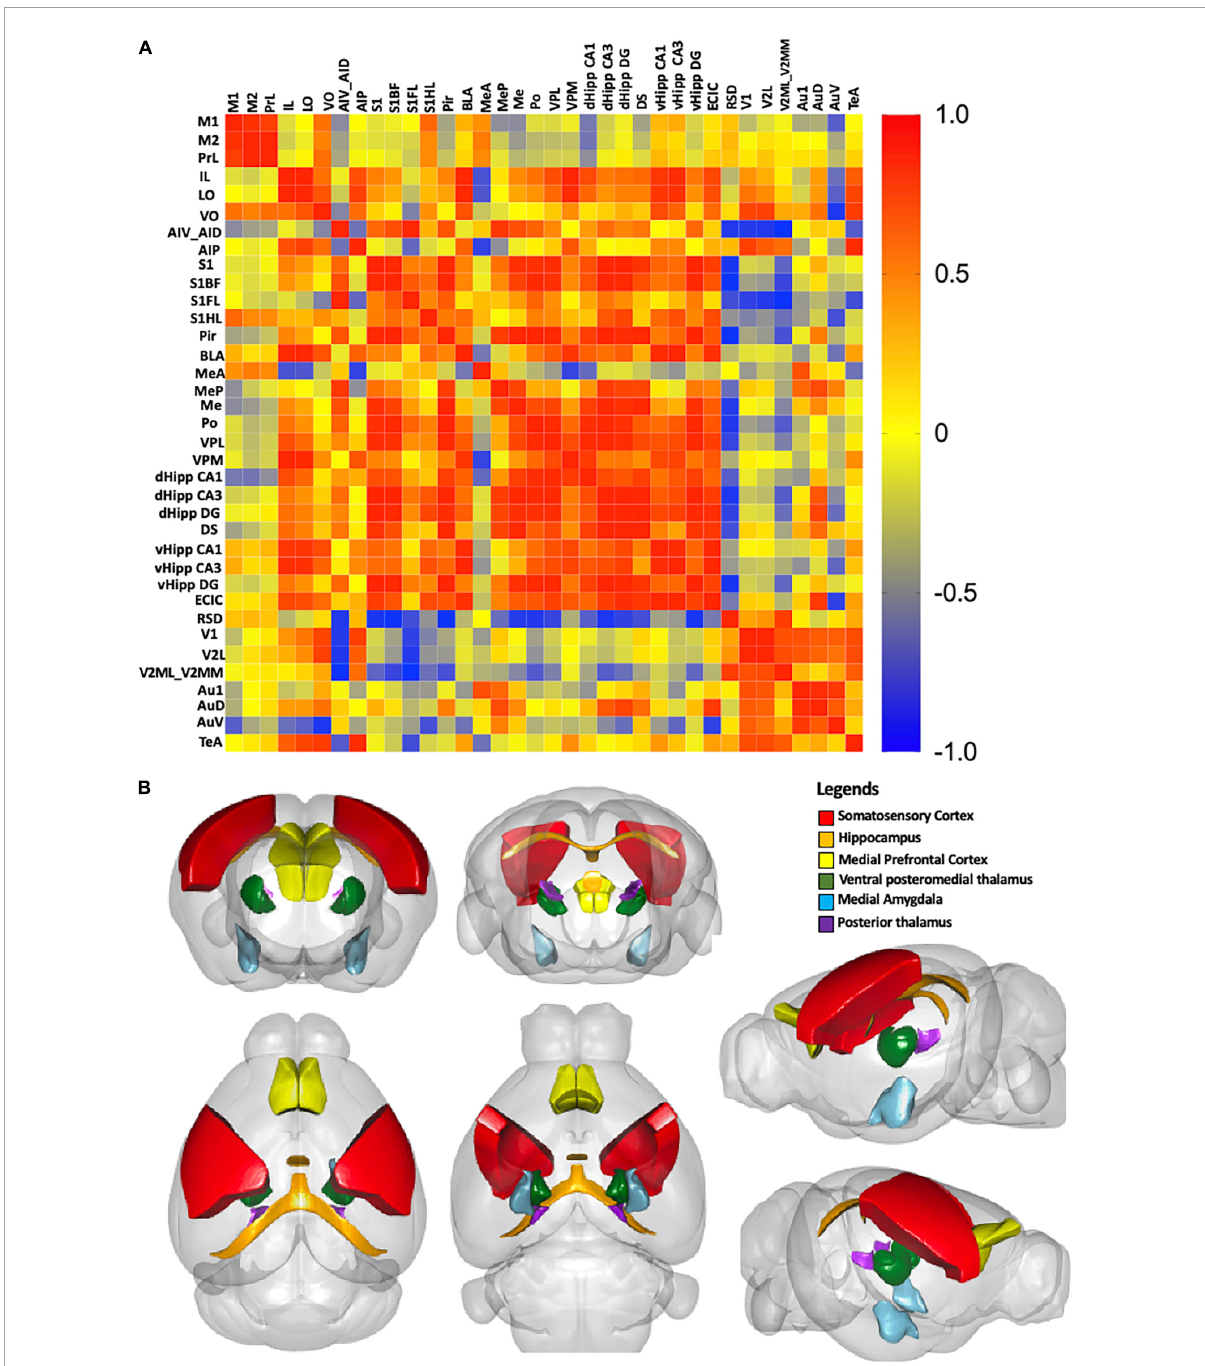
FIGURE9 (A) Correlation matrix with color scale. A correlation coefficient of 1 represents the maximum positive correlation, whereas, -1 represents the maximum negative correlation. Red indicates 1 and blue indicates -1. (B) A 3D model of the strongest correlated regions. Red represents the somatosensory cortex, orange represents the hippocampus, yellow represents the medial prefrontal cortex, darkgreen represents the ventral posteromedial thalamus, and skyblue represents the medial amygdala, purple presents the posterior thalamus.